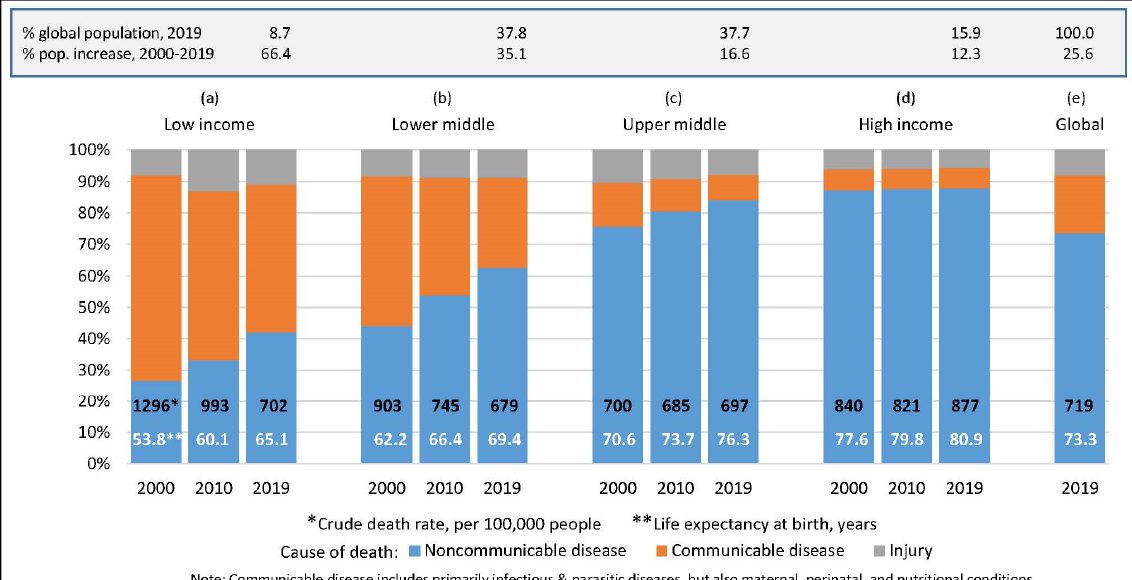
Figure 1. Trends in death rate, cause of death, and longevity at birth, by World Bank country income group, 2000–2019; All data available or calculated from data in the WHO’s online GHO database. For longevity: https://www.who.int/data/gho/data/indicators/indicator-details/GHO/life-expectancy-at-birth-(years). For all else: https://www.who.int/data/gho/data/themes/mortality-and-global-health-estimates/ghe-leading-causes-of-death (both accessed on 6 December 2021).